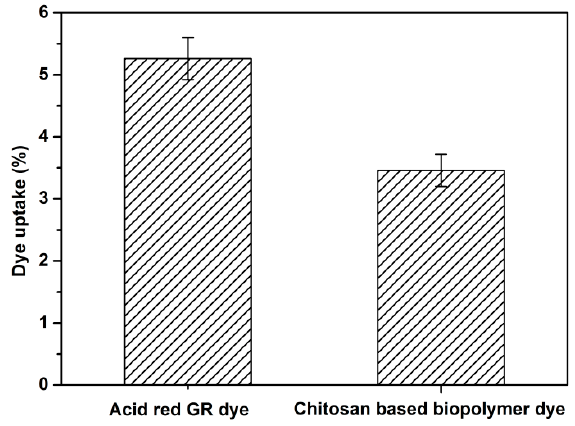
Figure 7. Dye uptake of Acid Red GR and chitosan-based biopolymer dye.